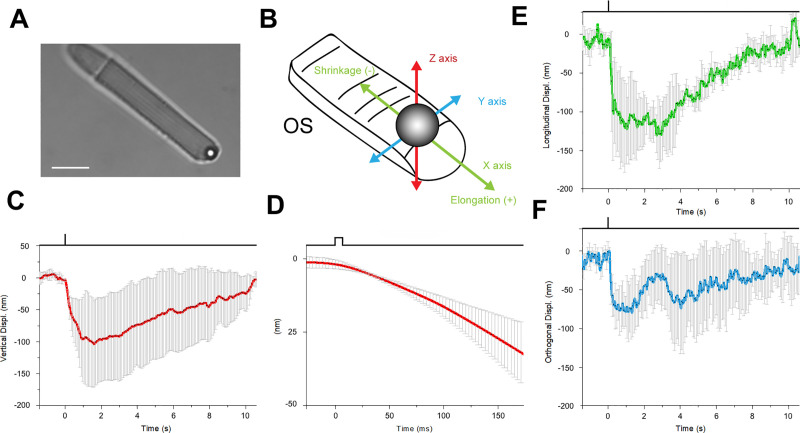
Mechanical response of an X. laevis rod to light flashes.The position of a bead sealed against the tip of the rod OS is monitored with OTs (see Methods). Following a bright flash of 491 nm, equivalent to about 104 R*, a transient shrinkage is observed. (A) Bright-field IR image, showing a trapped bead in contact with the tip of the rod OS (scale bar, 10 μm). (B) Detail of the 3D tracking system. (C) Light-induced shifts in the Z axis of the trapped bead (downward is negative). (D) Expansion of the time base in E to examine the delay between light stimulus and bead movement. (E) Bead displacement along the direction of the rod OS (shrinkage is negative, and elongation is positive). (F) Bead displacement in the direction perpendicular to the rod OS axis. Data are representative of mean ± SD of 5 different experiments. IR, infrared; OS, outer segment; OTs, optical tweezers.